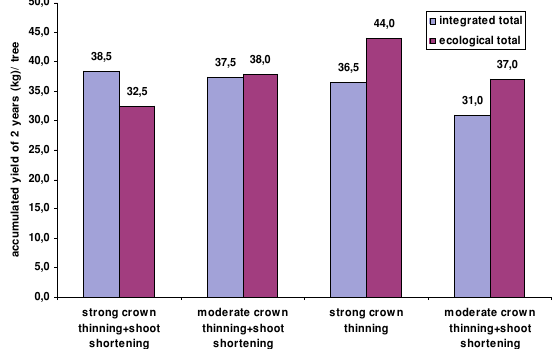
Figure 8. Consequence of the intensity and method of pruning on the accumulated yields of the to experimental trees (Debrecen-Pallag,